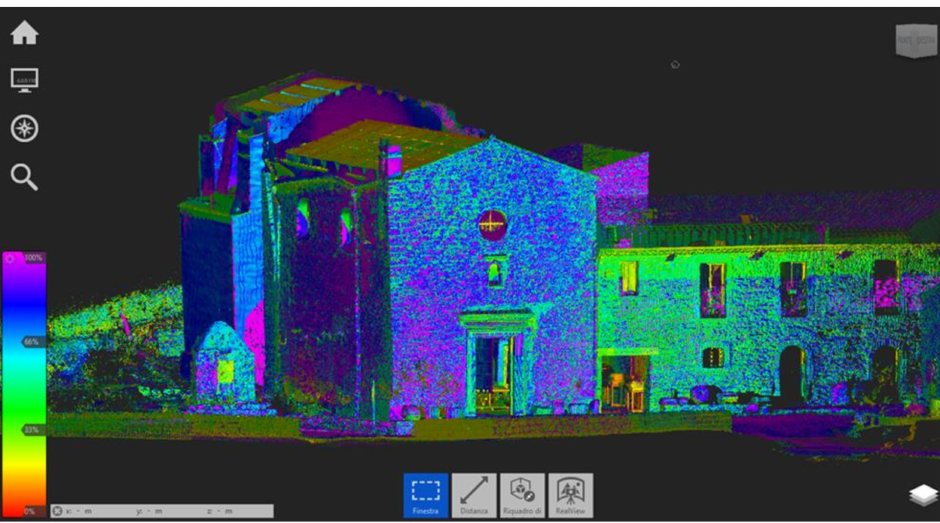
Figure 16. Recap elaboration: intensity map of the external area. The possibility of having a three-dimensional model available, searchable and imple- mentable at any time, allows us to have a basis for any type of study or detailed analysis, not only concerning the structural or architectural aspects of the building, but also for any restoration and/or consolidation of the architectural and decorative